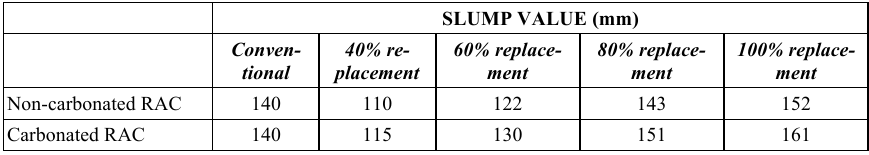
Table 3. Slump values for different